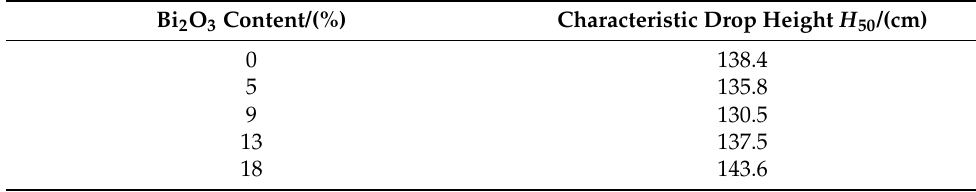
Figure 5. Drop-weight test results of PAB with different Bi 2 O 3 contents: ( a ) PA 1#; ( b ) 2#PAB-5%; ( c ) 3#PAB-9%; ( d ) 4# PAB-13%; ( e ) 5#PAB-18%. Table 3. H 50 of PAB with different Bi 2 O 3 contents.